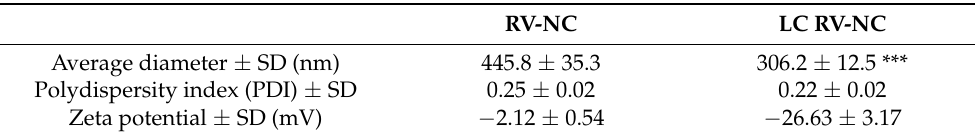
Table 1. Physico-chemical characteristics of RV nanocrystals (RV-NC) and lipid-coated RV nanocrystals (LC RV-NC). Each reported value is the average of 10 independent measurements of 3 different formulations. The data are presented as means ± standard deviation (SD). * p < 0.05; ** p < 0.01; *** p < 0.001 vs. RV-NC.